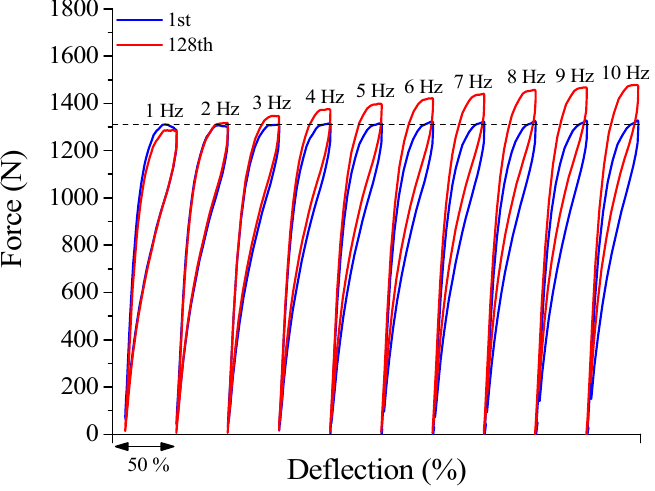
Figure 8. Dynamic response of the superelastic behavior for loading frequencies from 1 Hz to 10 Hz. The horizontal line is used to compare the force levels at the beginning of each cycle. From 2 Hz the peak force value for the 128th cycle increases in relation to the 1st